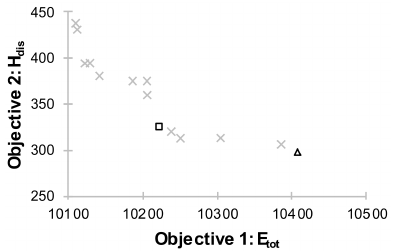
Figure 14. Pareto front for case